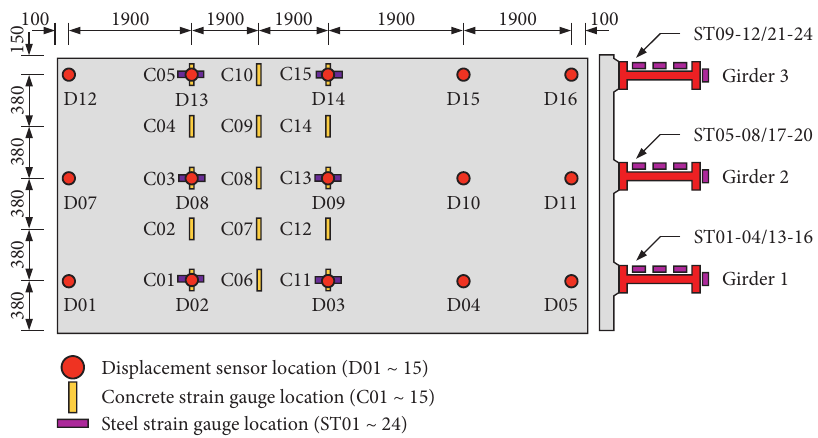
Figure 4: Instrumentation layout of static